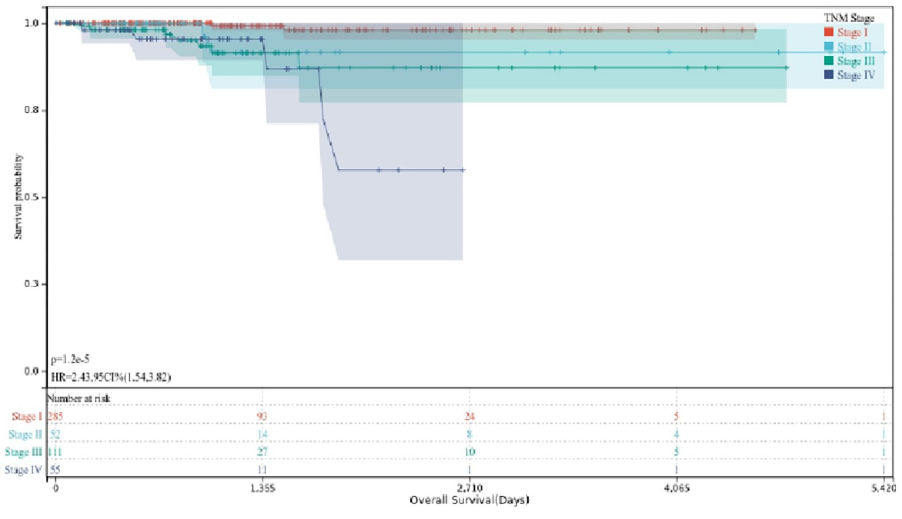
Fig 9. Survival curve of TNM